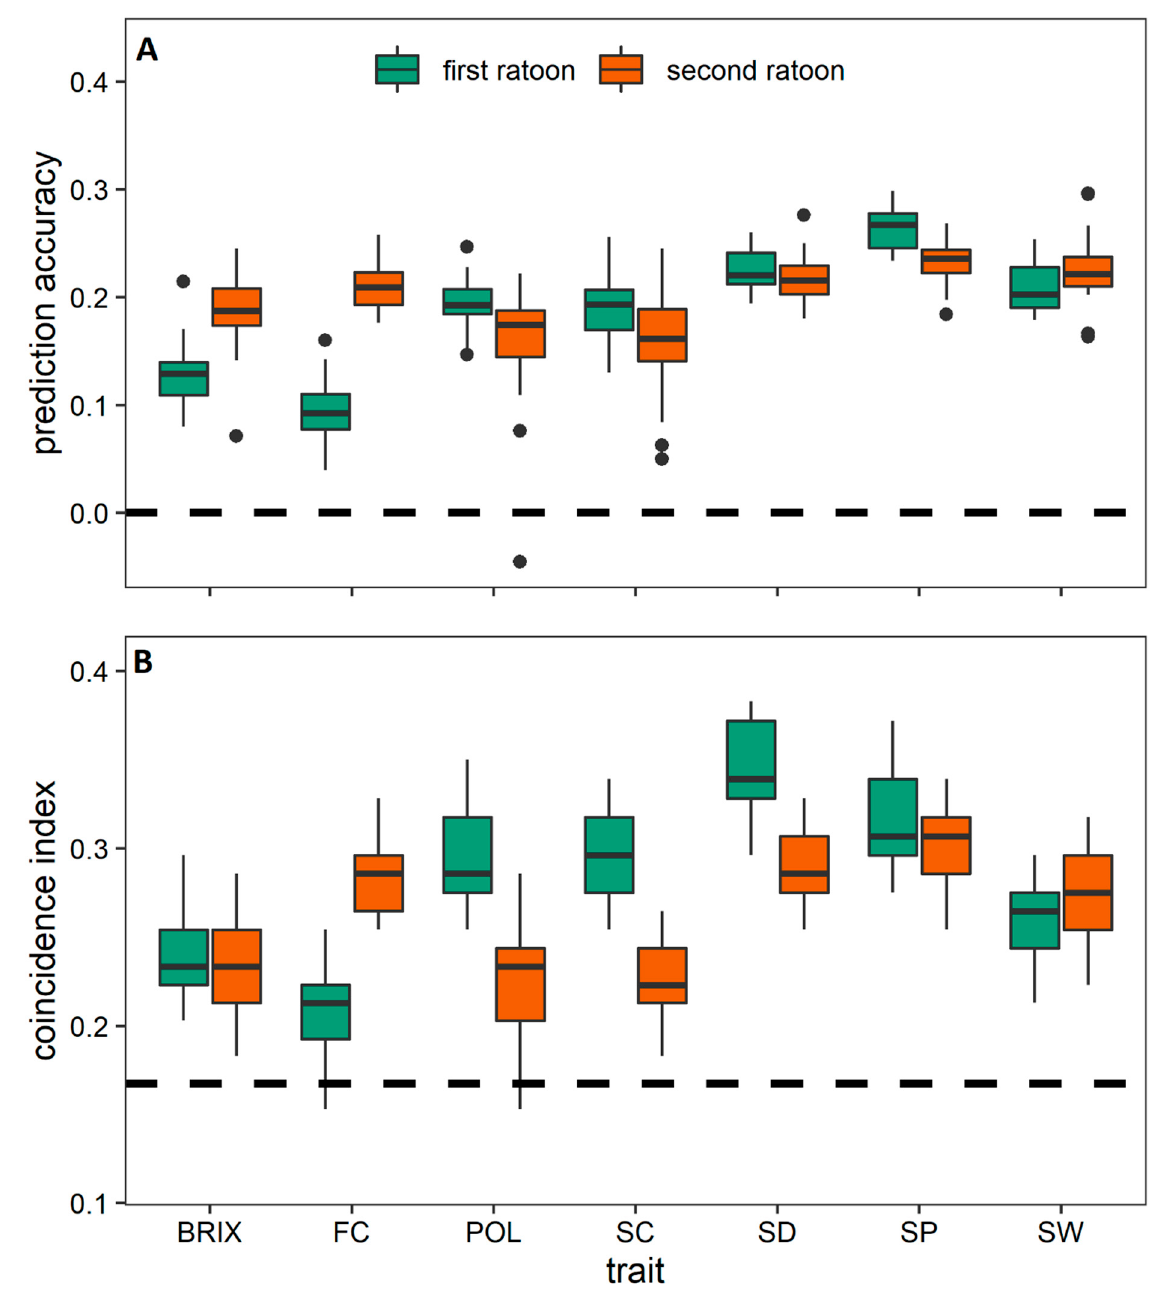
Figure 3. Prediction accuracy ( A ) and coincidence index ( B ) of the genomic estimated breeding estimated value (GEBV) of seven yield- and sugar-related traits for fivefold cross-validation (fivefold CV) of seven genomic selection (GS) methods. The fivefold CV was performed using plant cane data as the training set and ratoon data as the validation population. The seven traits were Brix, fiber content (FC), pol, sucrose content (SC), stalk diameter (SD), stalk population (SP), and stalk weight (SW).